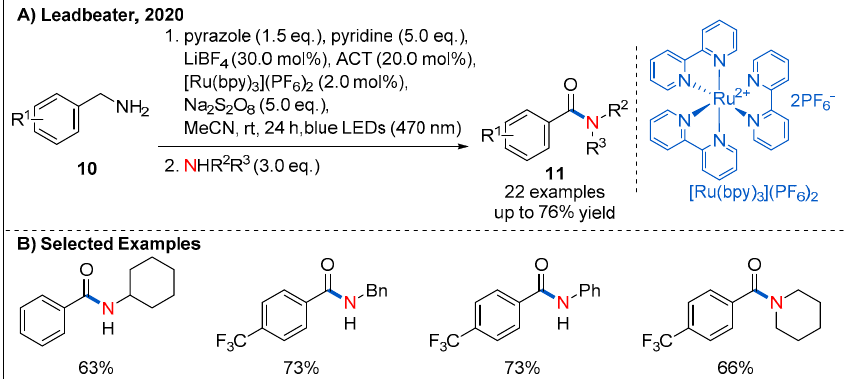
Figure 6. Oxidative amidation of amines and transamidation.